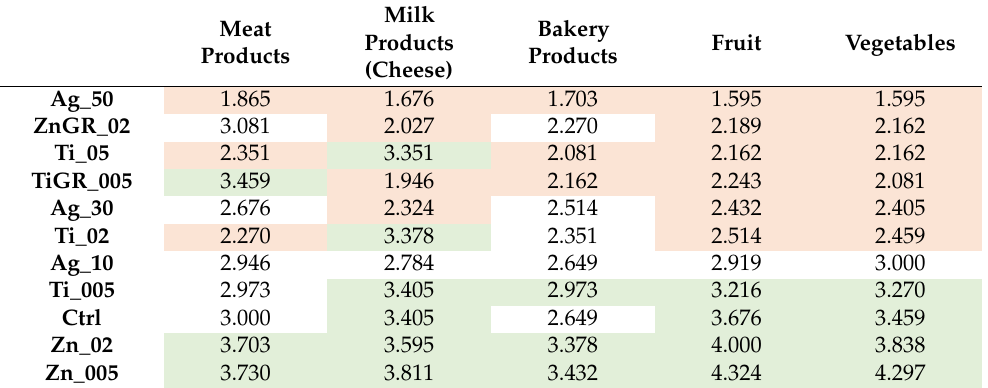
Table 4. Adjusted mean scores of the probability of purchasing a certain commodity in an edible